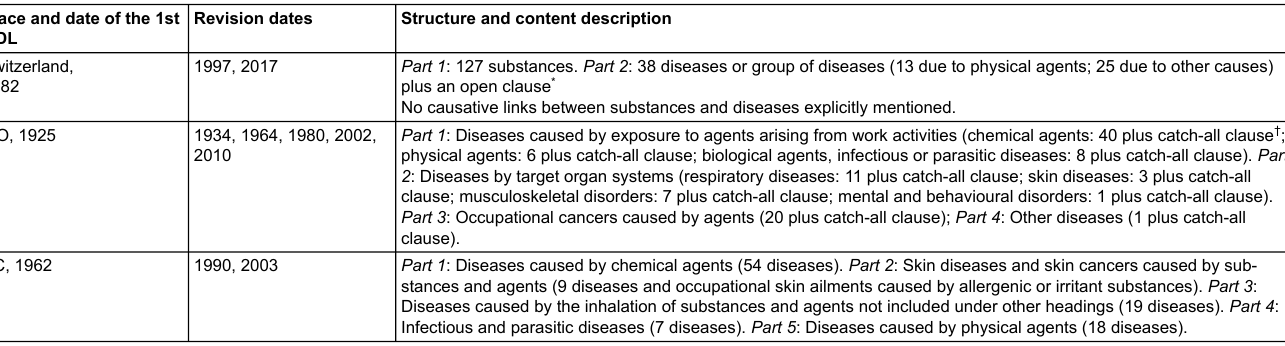
Table 1: Comparative assessment of the Swiss, ILO and EC occupational disease lists. Place and date of the 1st